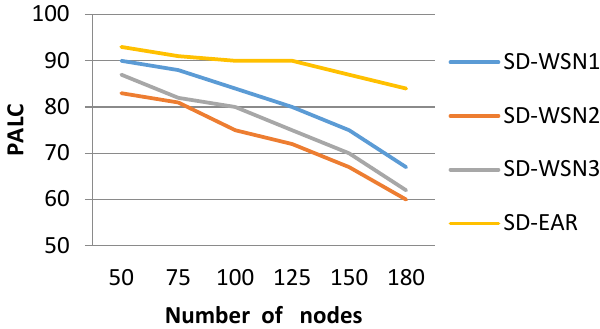
Figure 20. PALC vs. number of nodes.